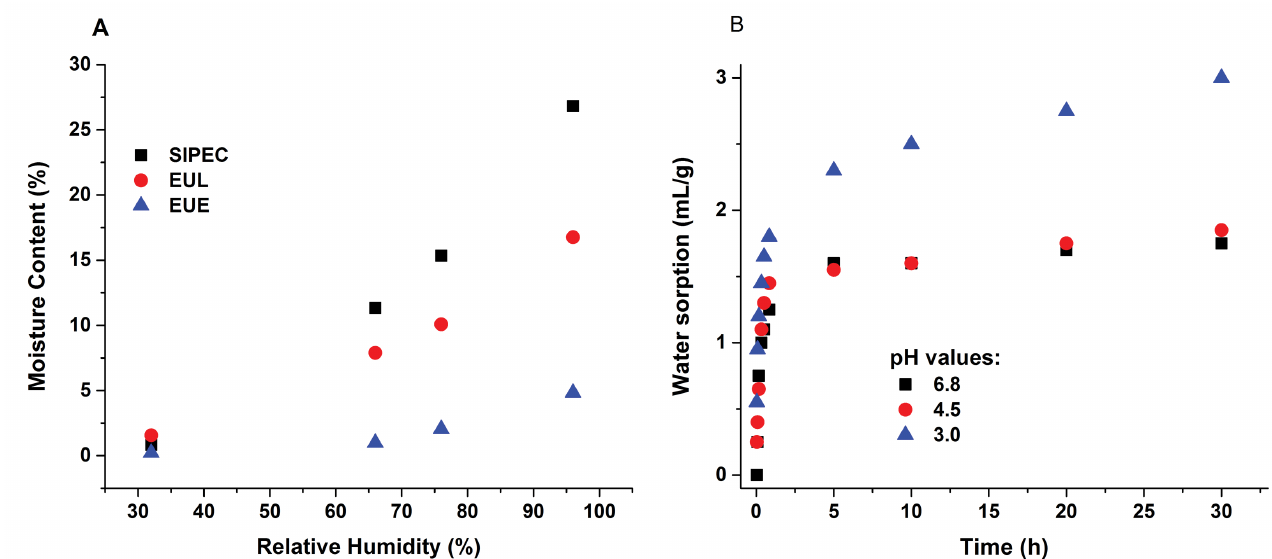
FIGURE 6 - A. Water sorption isotherms measured at 19 °C ± 1 °C of EUE, EUL, and the corresponding SIPEC. B. Swelling kinetics of SIPEC measured at different pH values.